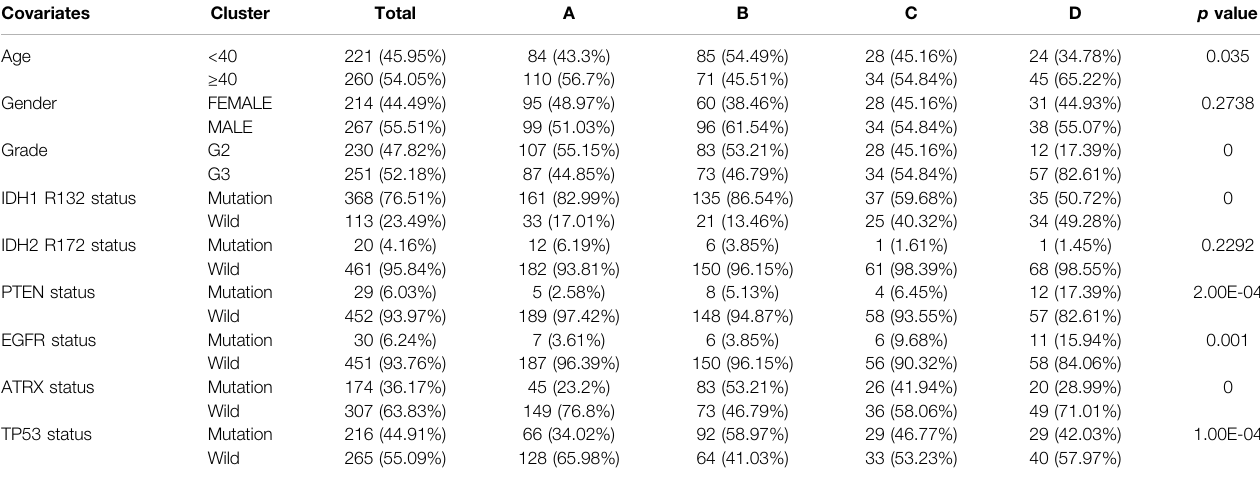
TABLE 1 | Correlations among the four immune clusters and clinical characteristics in the TCGA-LGG dataset.